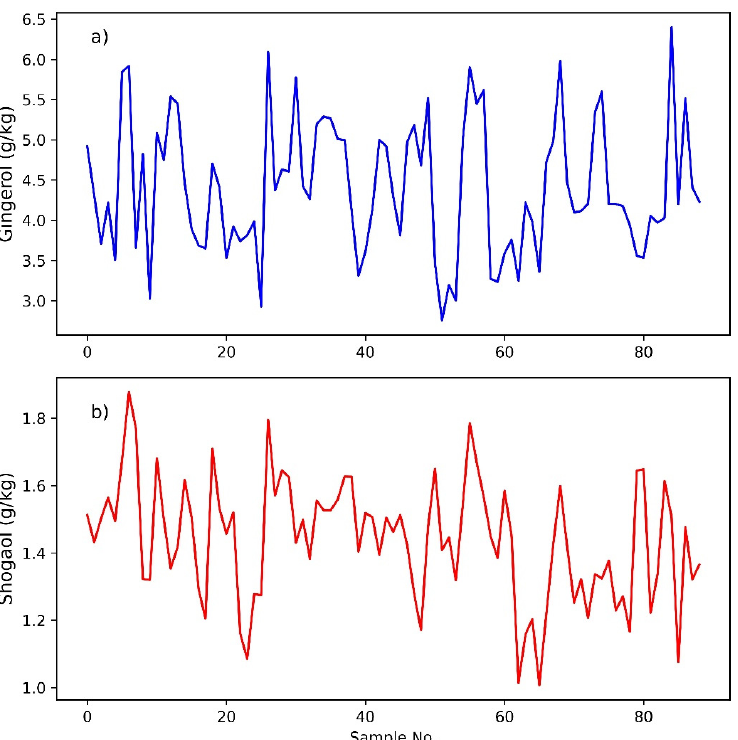
Figure 2. The concentration of 6-gingerol ( a ) and 6-shogaol ( b ) in the ginger samples, as measured by high-performance liquid chromatography analysis.